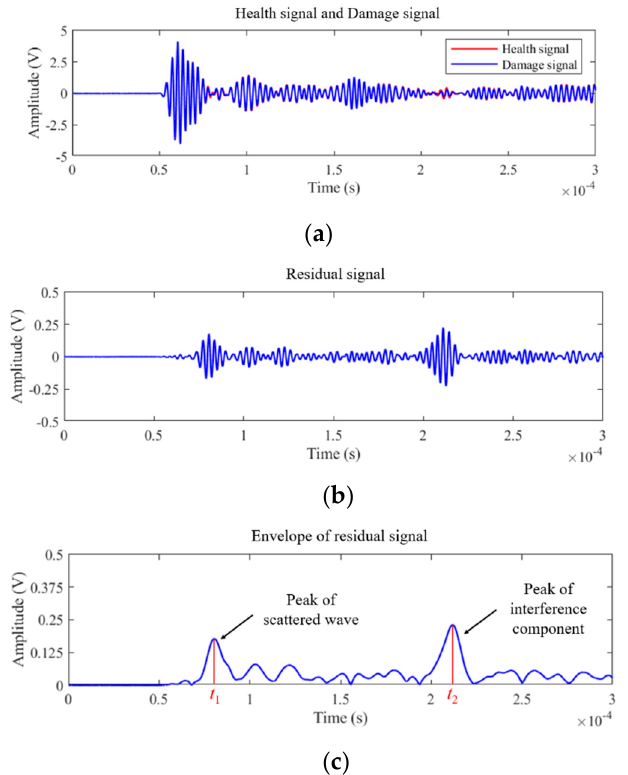
Figure 2. Signal processing of the traditional elliptic imaging method: ( a ) healthy signal and damaged signal; ( b ) residual signal obtained by baseline subtraction. ( c ) Envelope of residual signal.